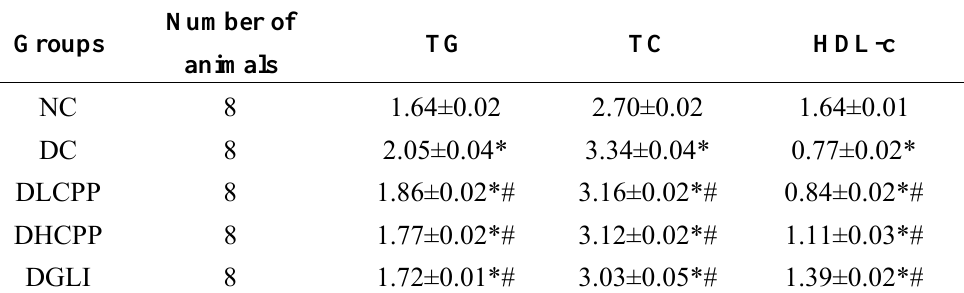
Table 3. Effect of CPP on blood lipids (mmol/L ) in